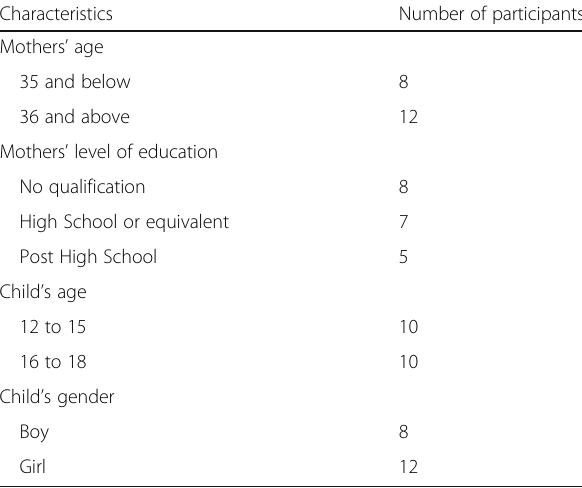
Table 1 Characteristics of participating mothers ( n = 20)